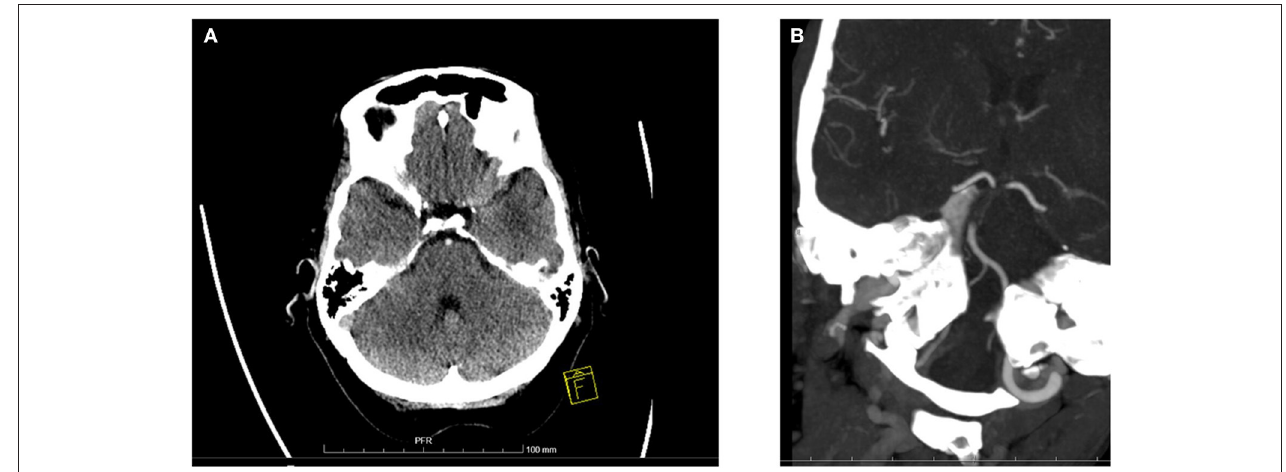
FIGURE 1 | Baseline ischemic changes and basilar artery occlusion in computer tomography. (A) A 69-year-old woman was comatose on admission (GCS 4) and diagnosed with basilar artery occlusion. This baseline CT scan shows extensive ischemic changes in both cerebellar hemispheres and bilaterally in pons. Overall pc-ASPECTS was 5. A dense basilar artery is also seen. Patient received IVT but died on day 3 of hospitalization. (B) A 65-year-old woman was comatose on admission (GCS 6). Baseline CTA shows long BAO over mid- and caudal BA. IVT was administered and subsequent mechanical thrombectomy was performed with successful recanalization. Patient recovered with a 3-month mRS of